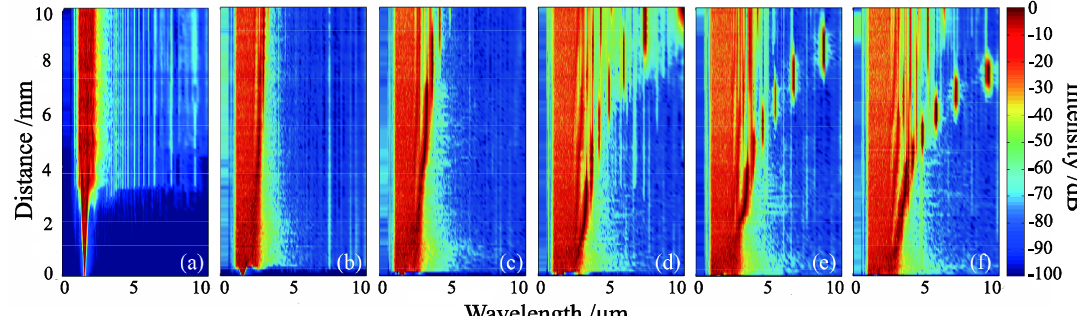
Figure 11. Simulated SCG at peak powers of ( a ) 1 kW, ( b ) 10 kW, ( c ) 20 kW, ( d ) 30 kW, ( e ) 40 kW and ( f ) 50 kW.